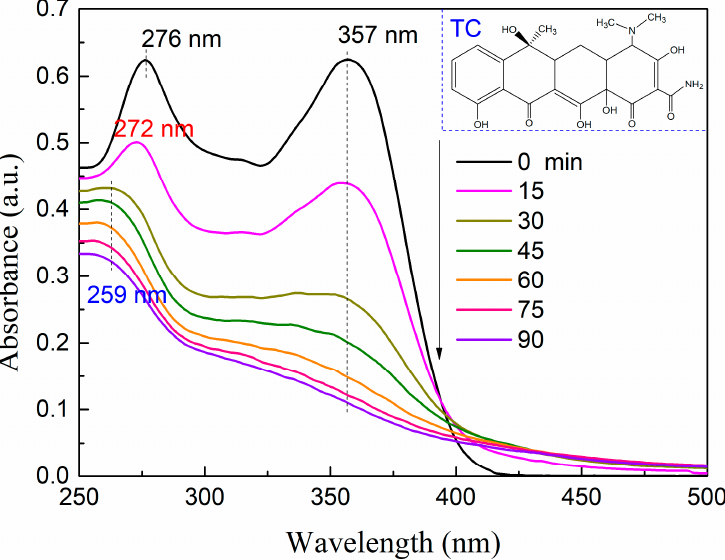
Figure 7. UV spectrum of oxidation degradation of TC in the presence of composite nanofiber membrane.